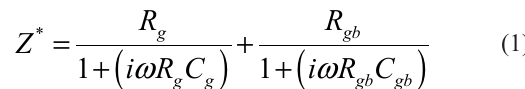
(100 kHz to 2 MHz) with very low values of